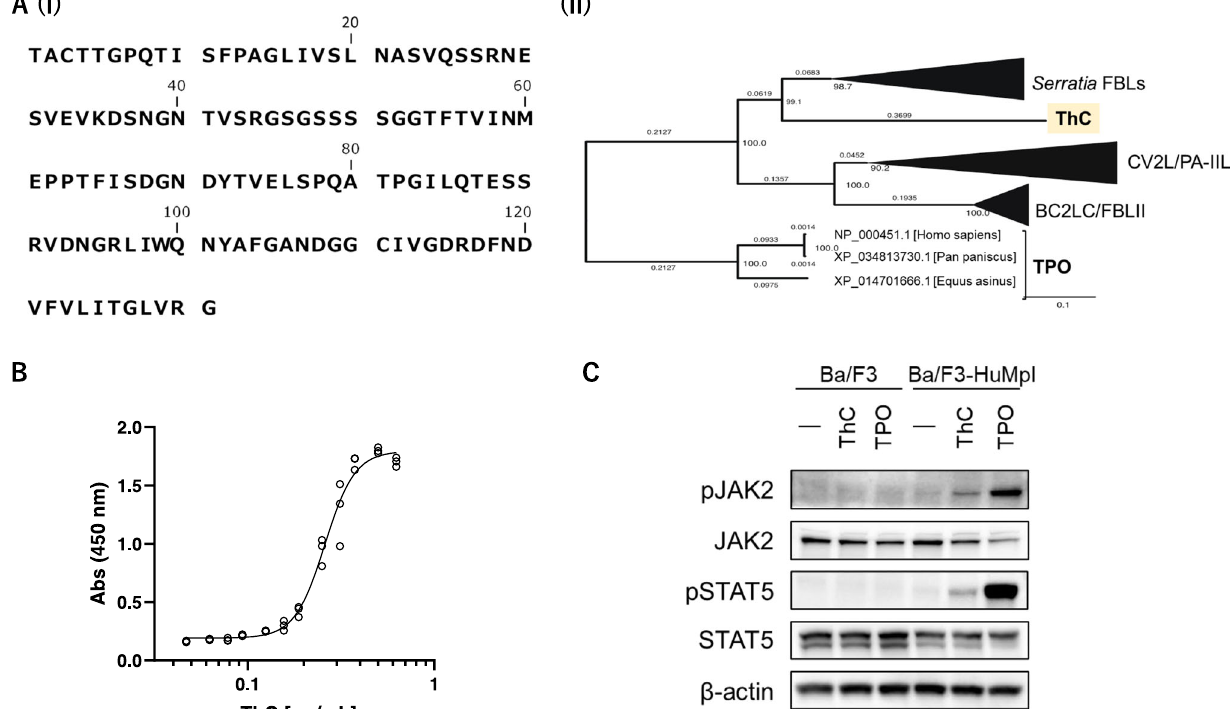
Fig. 1 | Biochemical pro fi les of ThC. A (i) Amino acid sequences of ThC. (ii) Phy- logenetic tree of ThC, related bacterial lectins and TPO with collapsed tree nodes (Supplementary Fig. 9). B Concentration – response curve of Ba/F3-HuMpl cells proliferatingbyrecombinantThC(rThC).Thehalf-maximaleffectiveconcentration EC 50 was0.26(95%CIof0.25 – 0.27)and0.31 μ g/mL(18.6and22.1nM,respectively)